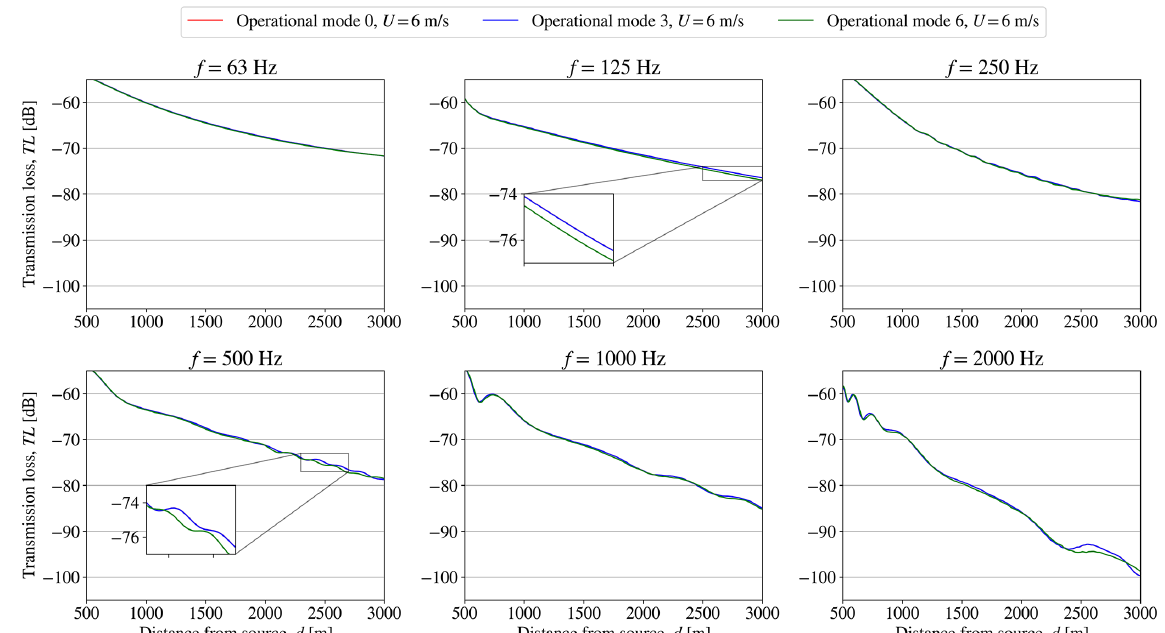
Figure A1. Setup 1: C T sensitivity of WindSTAR obtained transmission loss, TL, from a single wind turbine subject to changing operational modes at each octave band frequency at a free field wind speed of U 0 = 6ms − 1 .